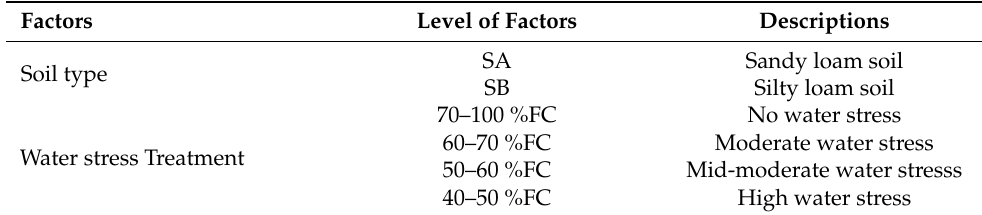
Table 1. Factorial design for water stress levels and soil type. Factors Level of